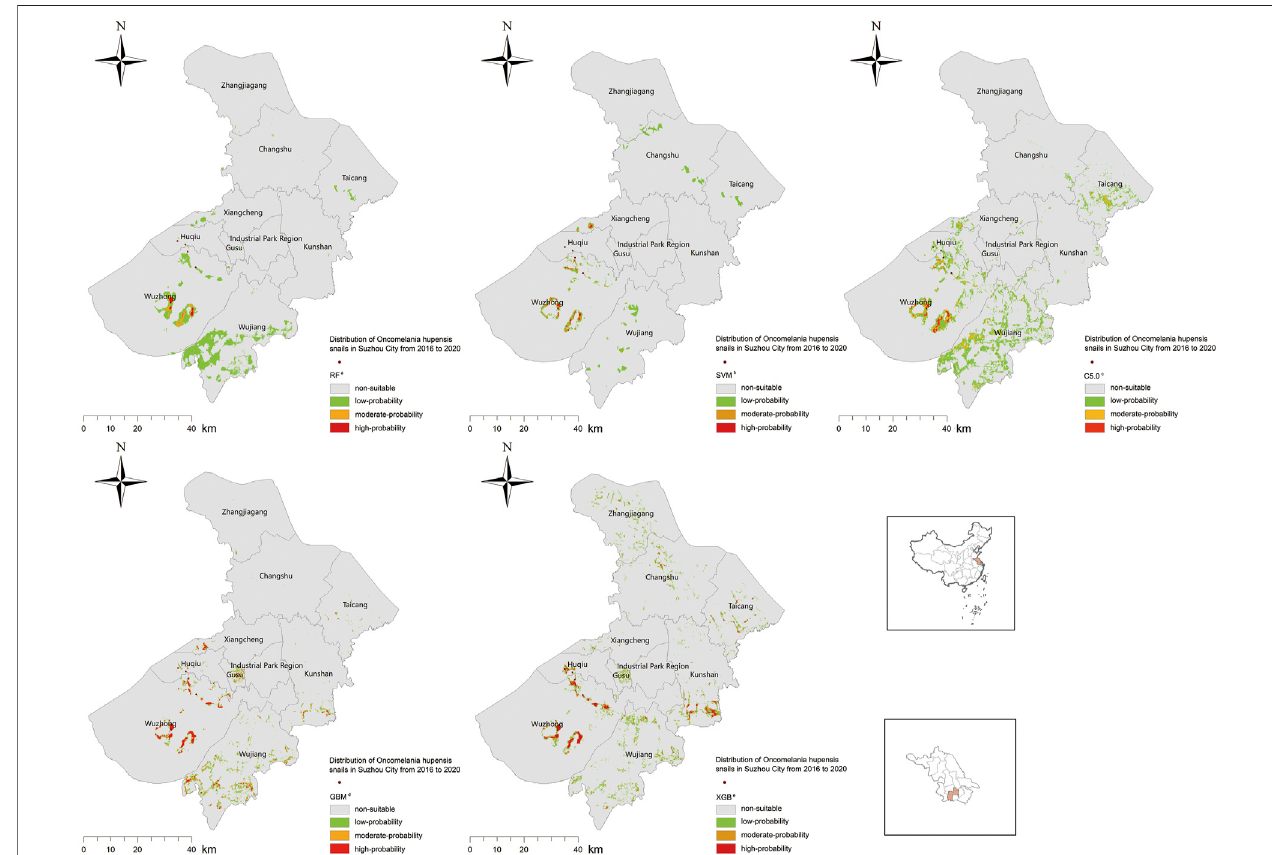
FIGURE 2 | Prediction of suitable habitats of Oncomelania hupensis using fi ve ecological niche models.